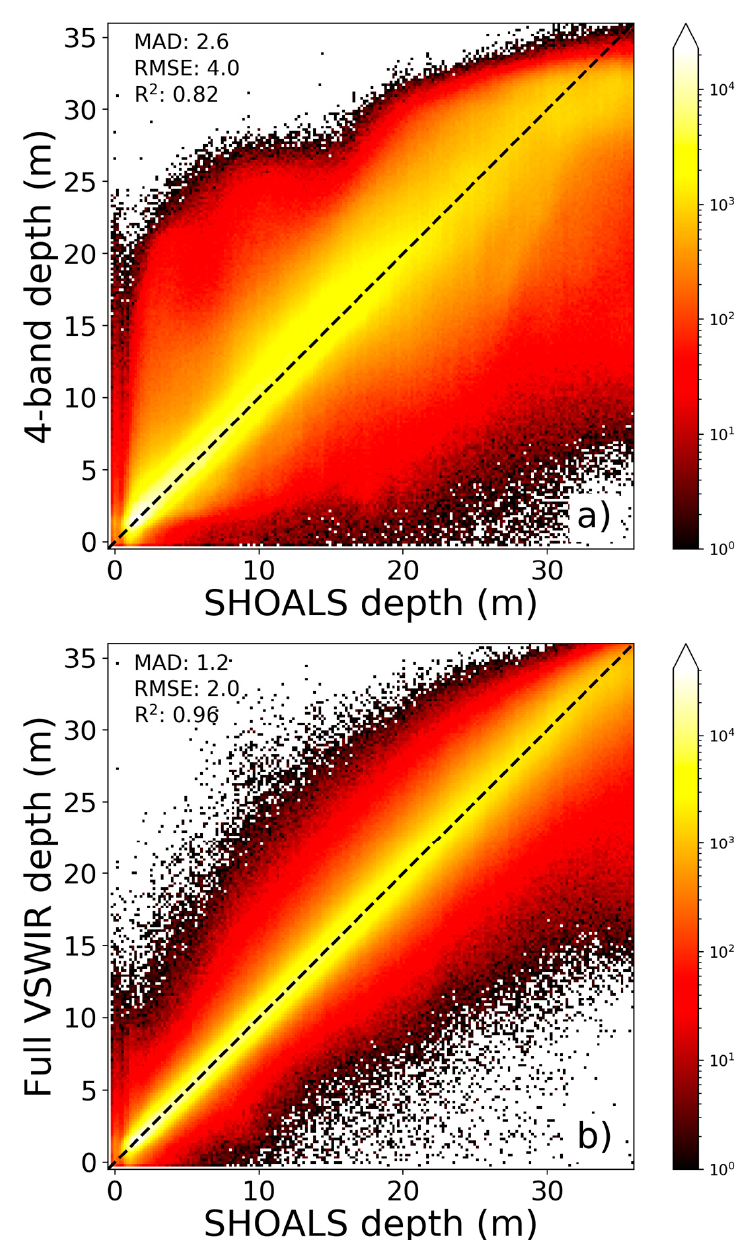
Figure 3. Heat map scatterplots of the bathymetric values estimated from a neural network model applied to ( a ) simulated 4-band multispectral imagery and ( b ) the full VSWIR imaging spectroscopy compared to SHOALS-measured depth. Color represents point density. Isolated points of noise are typically pixels with a high amount of sea surface glint or shaded pixels, both of which can be removed from final maps.